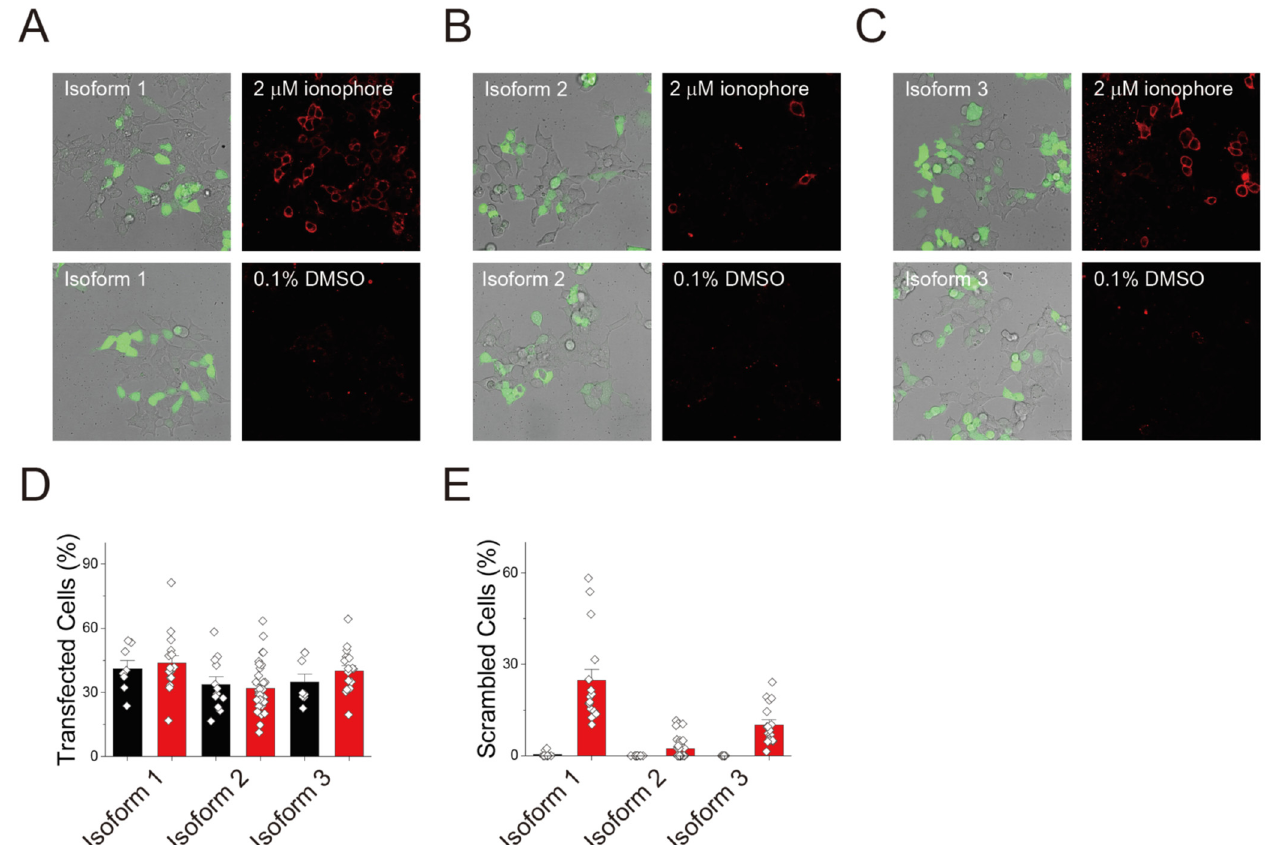
Figure 3. Scrambling activity of three human TMEM16C isoforms without GFP tagging. Monitoring of the lipid-transporting activity of TMEM16C isoform 1 ( A ), isoform 2 ( B ), and isoform 3 ( C ). A total of 293T cells were transfected with each isoform, without a GFP tag. To confirm transfection, a pCAG-GFP construct was co-transfected with TMEM16C at a ratio of 100:1 (TMEM16C:GFP). 2 µ M ionophore was used to increase intracellular Ca 2+ concentration; DMSO (0.1%) was used as a control. ( D ) Transfection efficiency of each isoform. The percentage of transfected cells was calculated for ionophore- (red bars) and DMSO-treated cells (black bars) by counting the total cells in brightfield images and GFP-expressing cells in fluorescence images. ( E ) Quantification of scrambling activity of human TMEM16C isoforms after treatment with a control (DMSO) or 2 μ M ionophore. Data are presented as mean + SEM. Isoform 1: DMSO, n = 9 and ionophore, n = 16; isoform 2: DMSO, n = 12